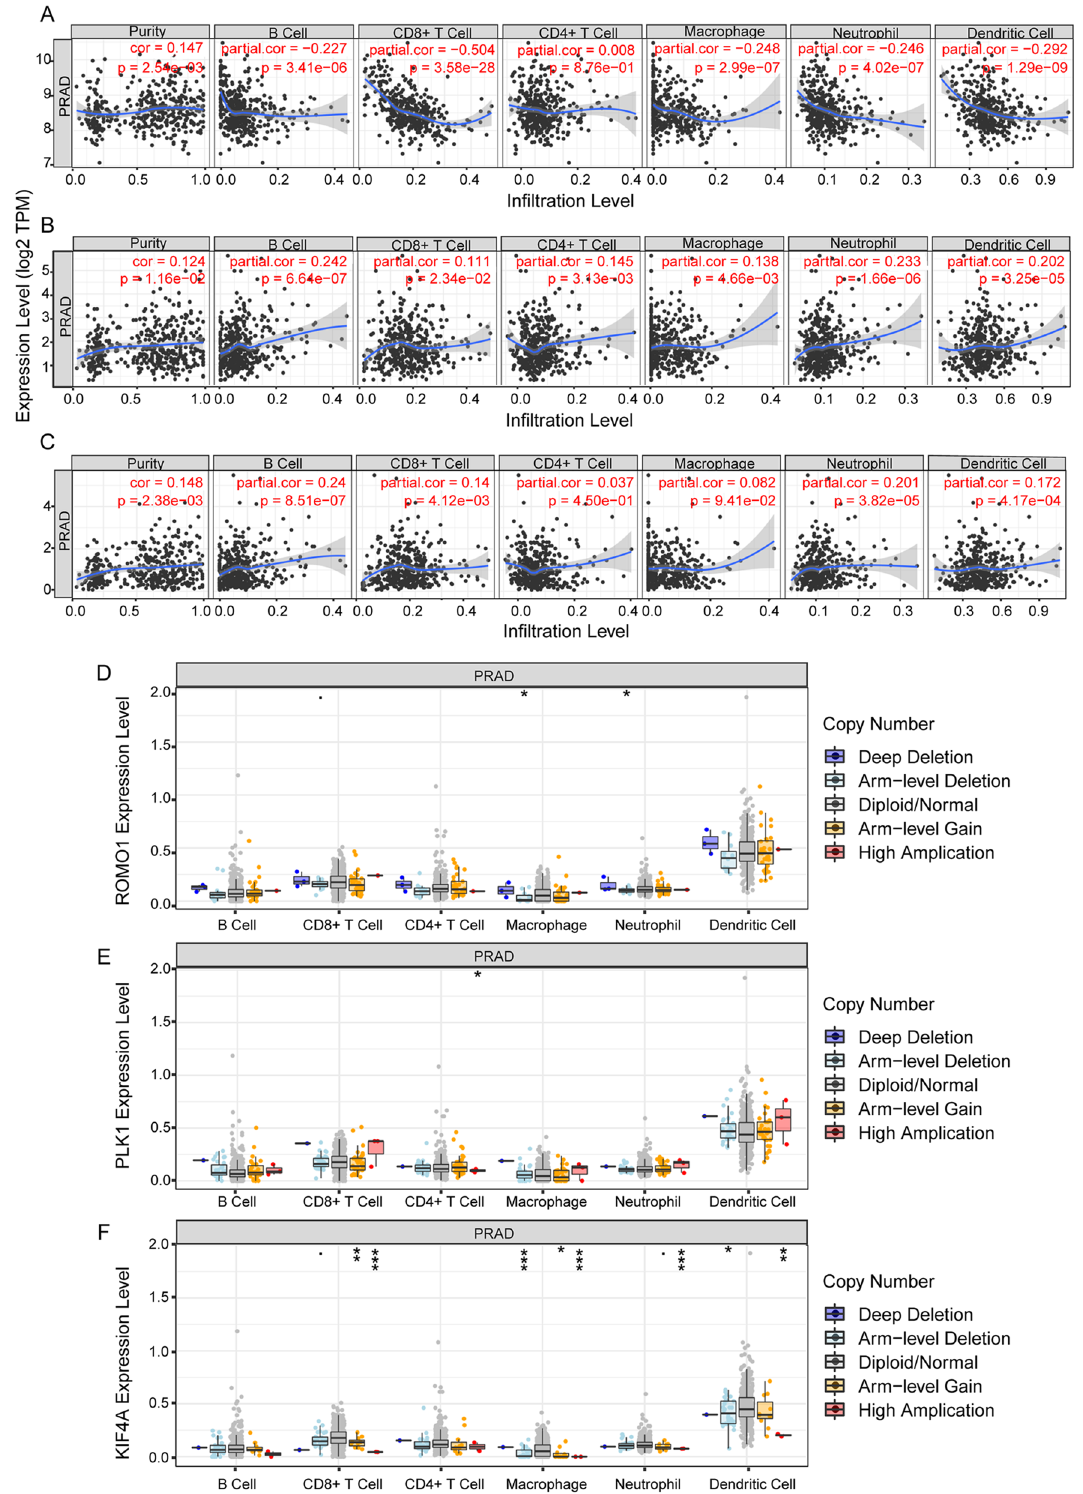
Figure 10. Immune relevance of three hub genes in PCa based on Tumor Immune Estimation Resource (TIMER). ( A – C ) Correlation study of ROMO1, PLK1 and KIF4A expression with six immune infiltrations, including CD4 + T cells, CD8 + T cells, B cells, macrophages, Neutrophils, and dendritic cells. ( D – F ) Boxplot shows the comparison of the tumor infiltration levels of ROMO1, PLK1 and KIF4A in immune cells with copy number variants in four categories. * P < 0.05, ** P < 0.01, *** P <